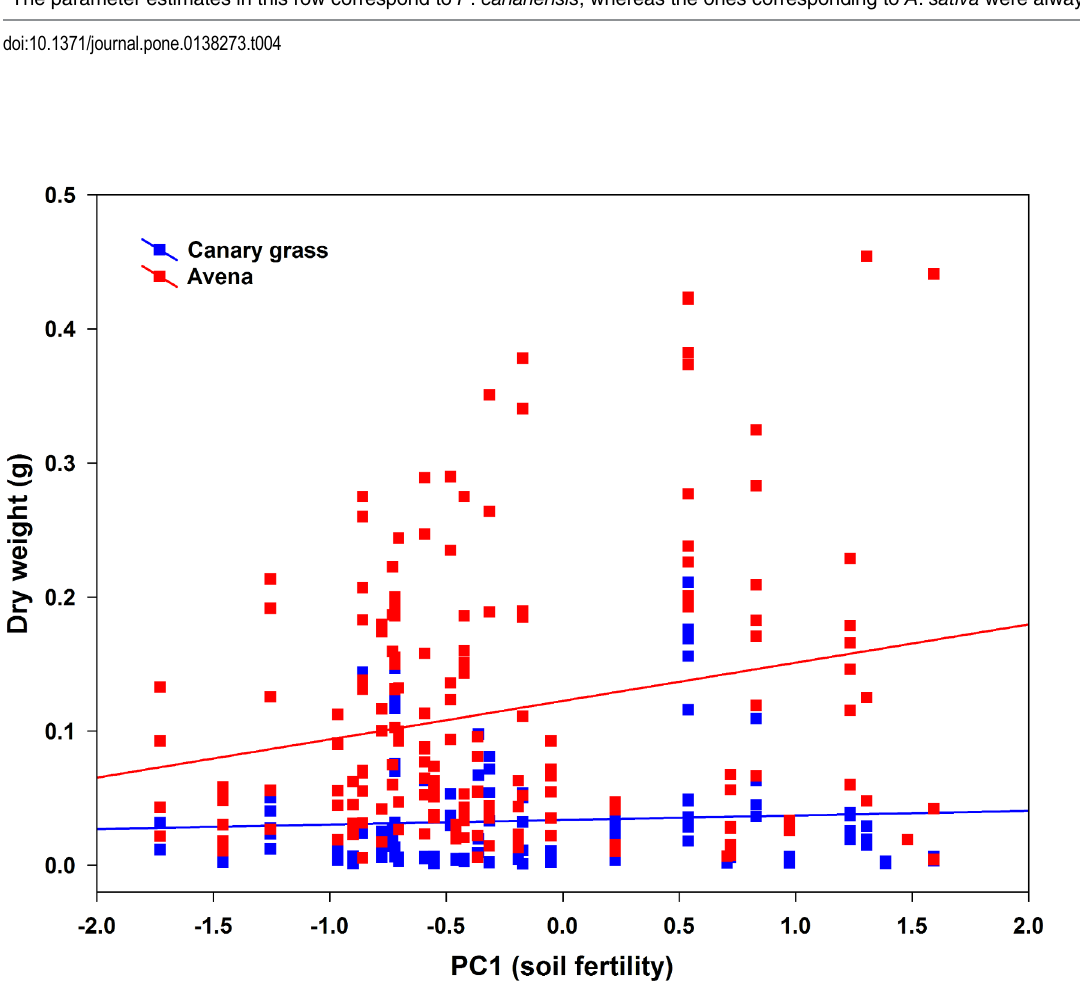
Fig 3. Positive linear relationships between seedling dry weight (g) and soil fertility (PC1) for the Canary grass (r = 0.054, P = 0.515, R 2 = 0.003) and Avena (r = 0.214, P = 0.004, R 2 = 0.046). Note that even though both species show a positive relationship, it only was significant for